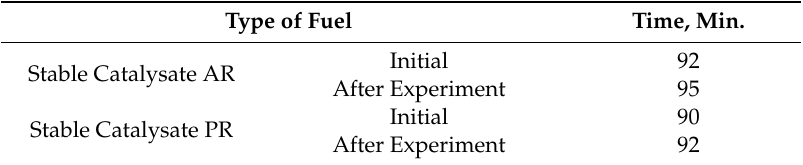
Table 6. The amount of toxic substances contained in the exhaust gases of the ICE. Stable Catalysate AR Stable Catalysate PR Component Initial After Exp. Initial After Exp. CO, ppm